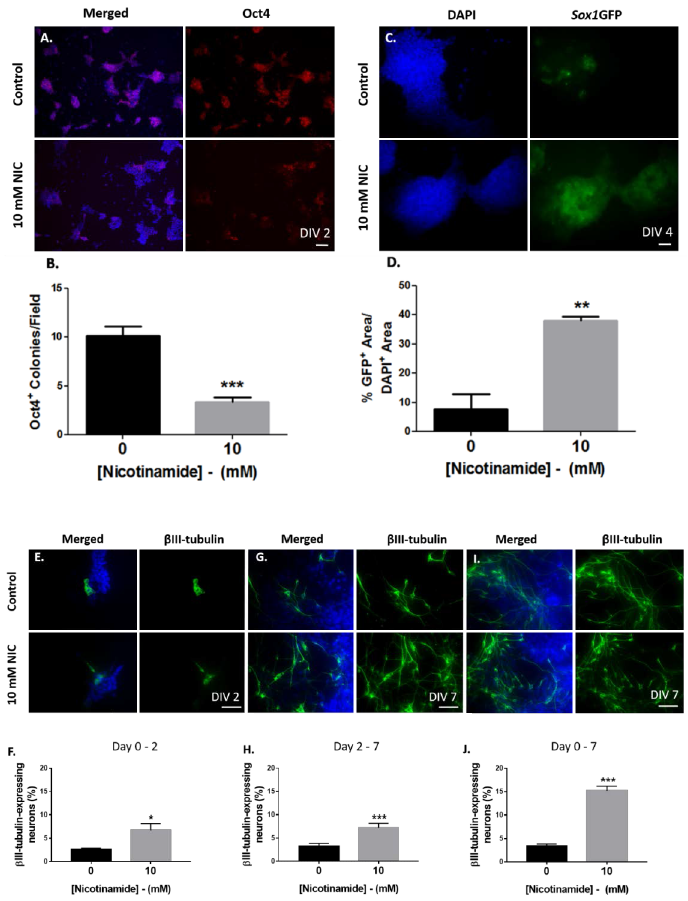
Fig 2. Nicotinamide accelerated neural specification of Sox1 GFP mESCs. Nicotinamide treatment significantly decreased Oct4 + pluripotentcells (A-B) and concomitantlyincreasedGFP + cells (C-D) at day 4, suggestingenhanced neurallineagecommitment. The effect of nicotinamide on immature neuronexpression was assessedduringmonolayerculture periods; (E-F) day 0–2, (G-H) day 2–7 and (I-J) day 0–7. Scale bar 100 μ m appliesto all low magnification images. *** p < 0.001, ** p < 0.01, * p < 0.05.